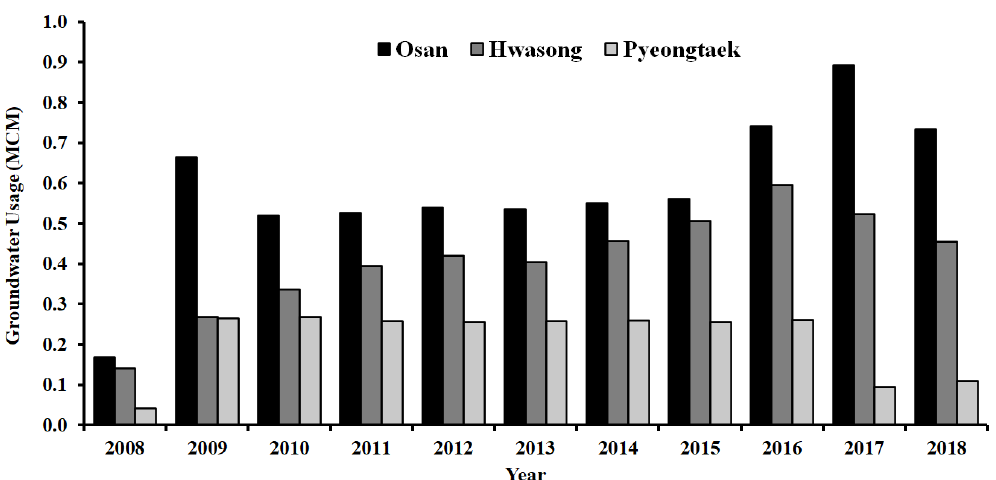
Figure 3. Yearly groundwater usage in the Osan watershed.